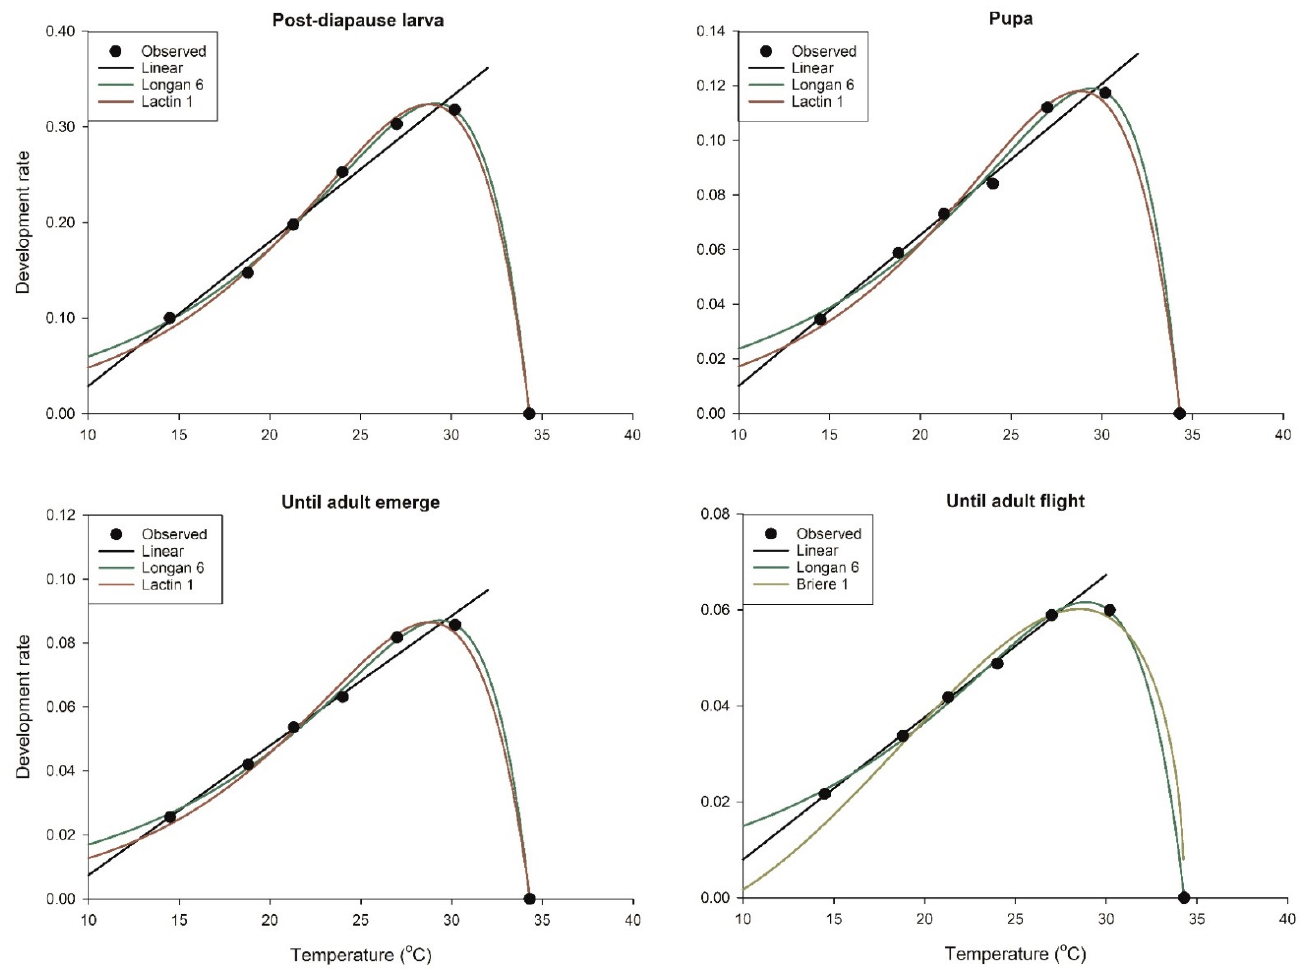
Figure 1. The linear and non-linear models fitted to the observed development rate of various stages of Eurytoma maslovskii after diapause